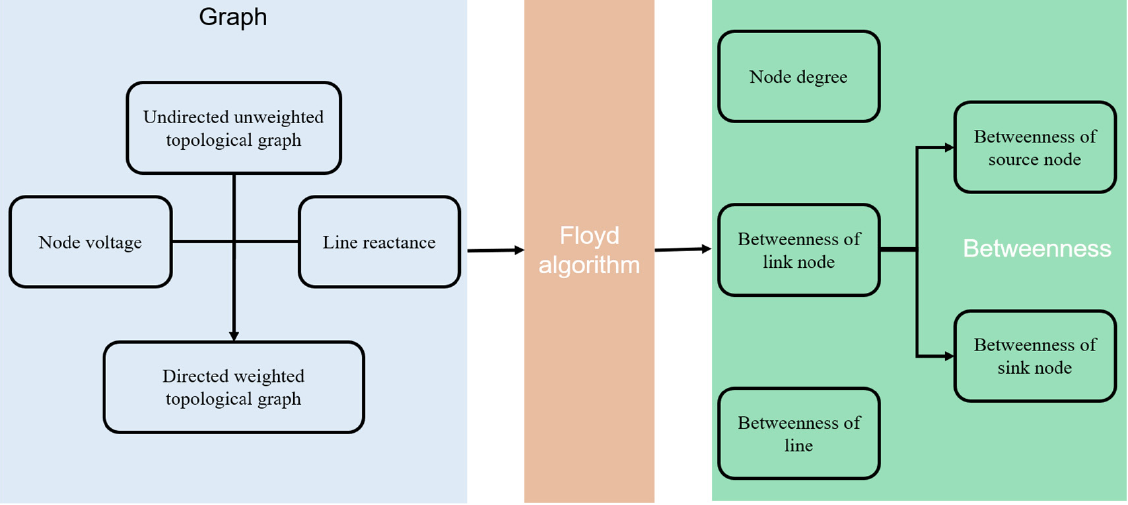
Figure 7. Flow chart of power grid topology modeling.